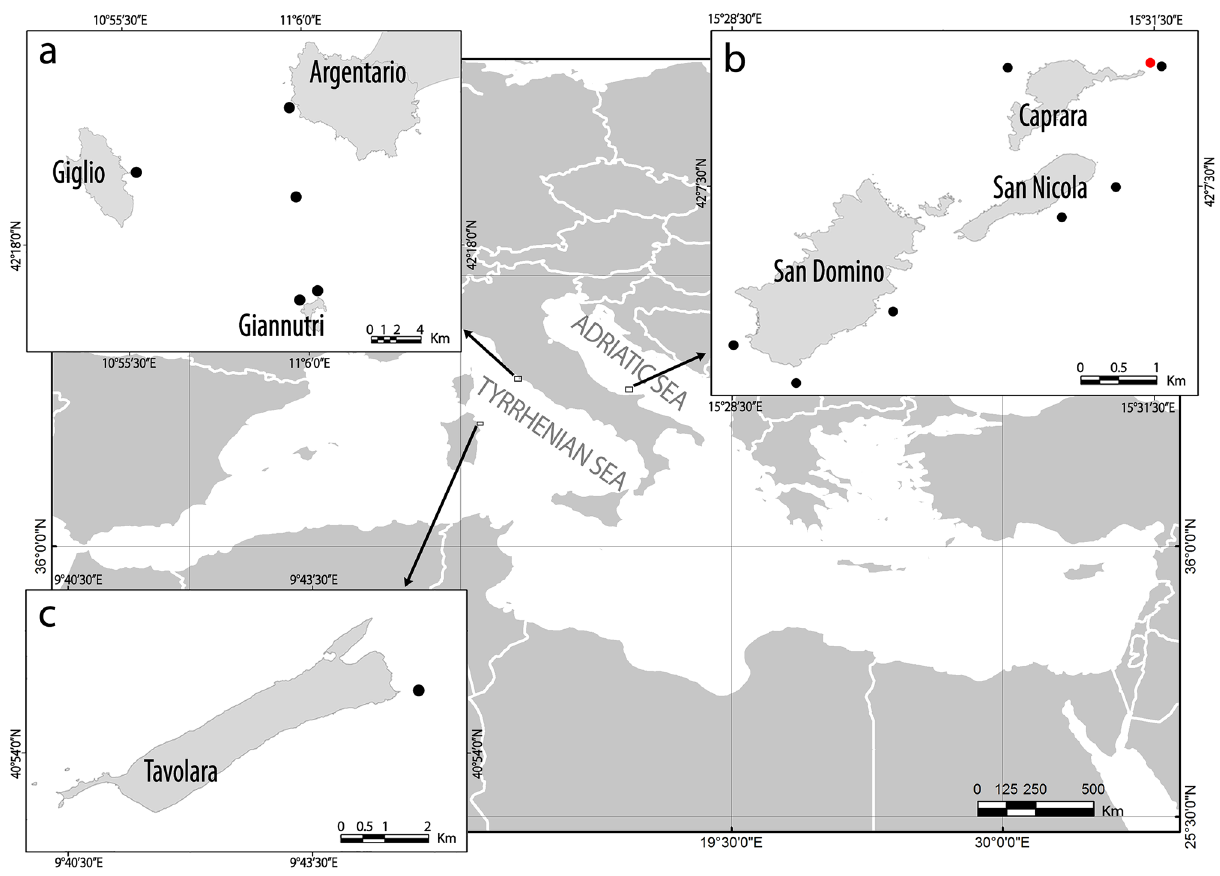
Figure 1. Map of the study areas, with details of ( a ) Tuscan Archipelago; ( b ) Tremiti Archipelago; ( c ) Tavolara Island. The study site of Punta Secca shoal is represented with a red dot, while the other unquantified occurrences of macroalgal epibiosis on gorgonians are represented with black dots. Maps have been created using ESRI ARCMAP 10.2 (https:// suppo rt. esri. com/ en/ produ cts/ deskt op/ arcgis- deskt op/ arcmap/